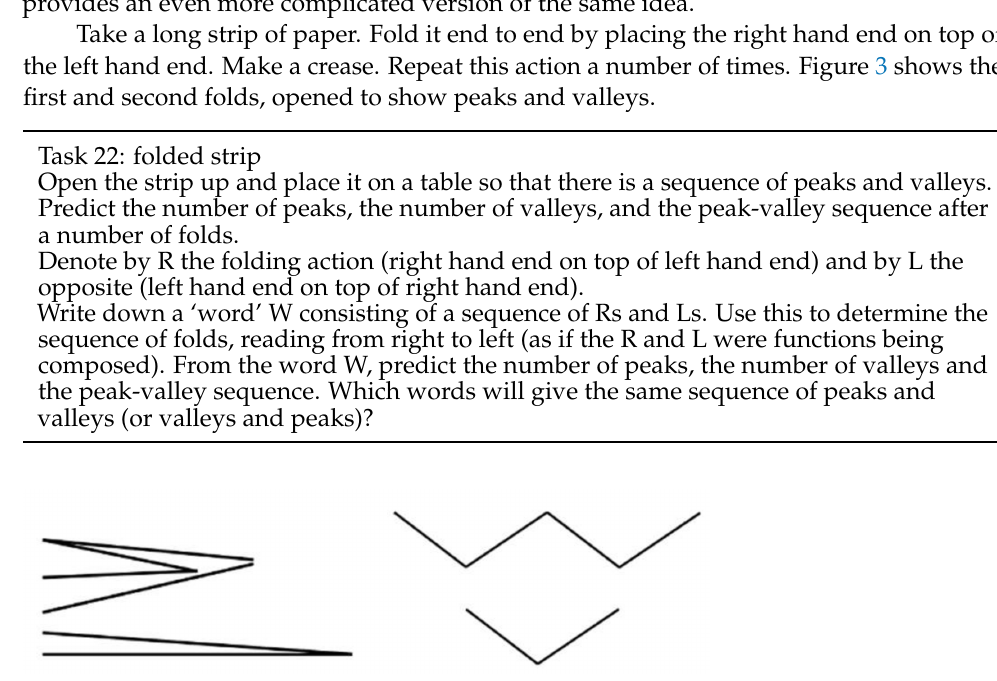
Figure 3. First two folds and corresponding peaks and